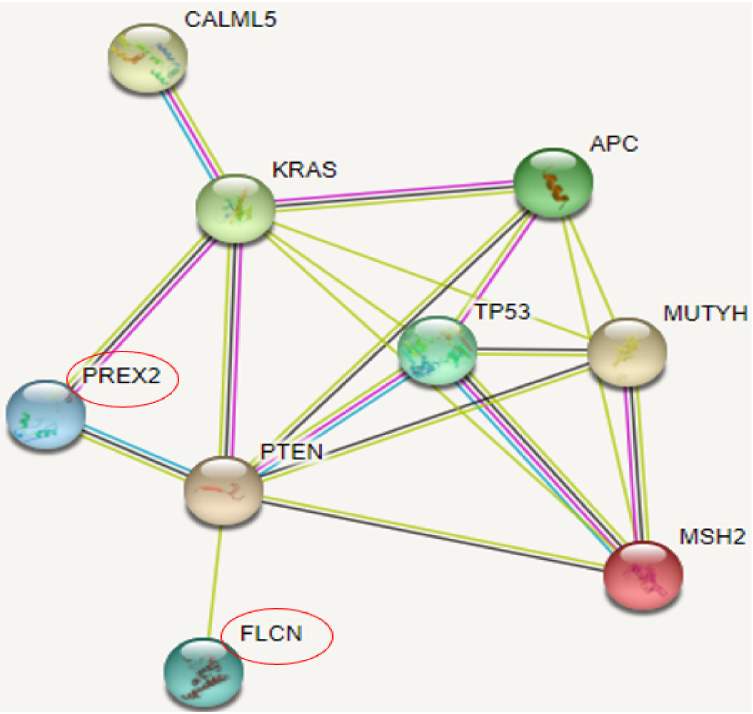
Figure 5. CR genes and their association with rectal cancer related genes in